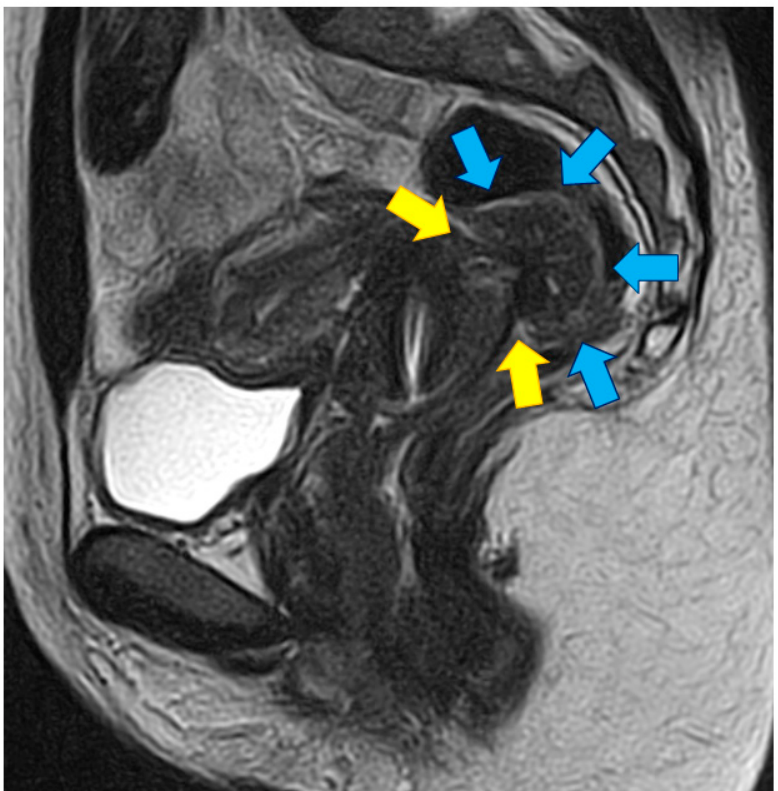
Figure 1. Pelvic MRI with a T2-weighted sagittal view of a DE nodule (blue arrow) invading the anterior rectal wall. The nodule infiltrates the anterior rectal wall at the level of posterior part of the cervix (yellow arrow).